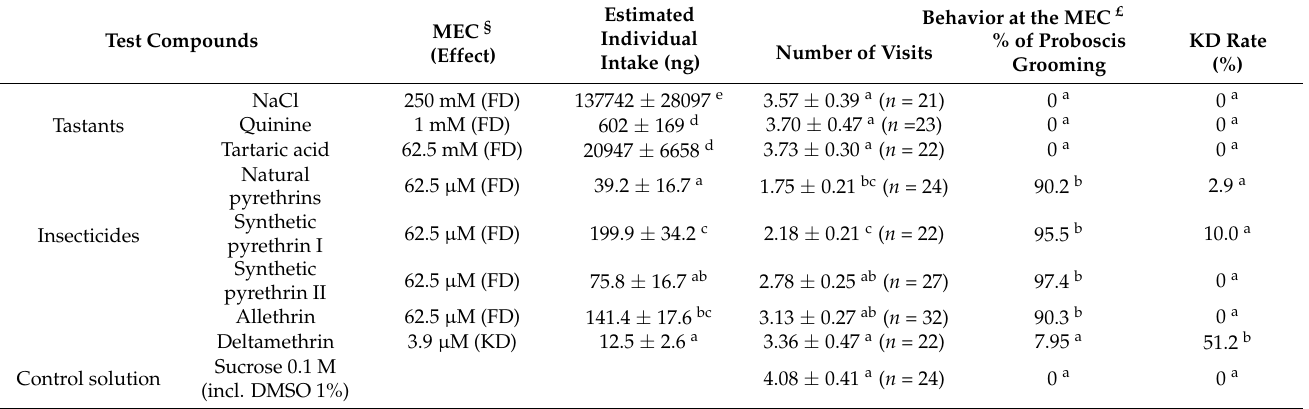
Table 1. Phormia regina feeding behavior and knockdown rates at a minimum effective concentration (MEC) of pyrethrins, pyrethroids, and unpalatable